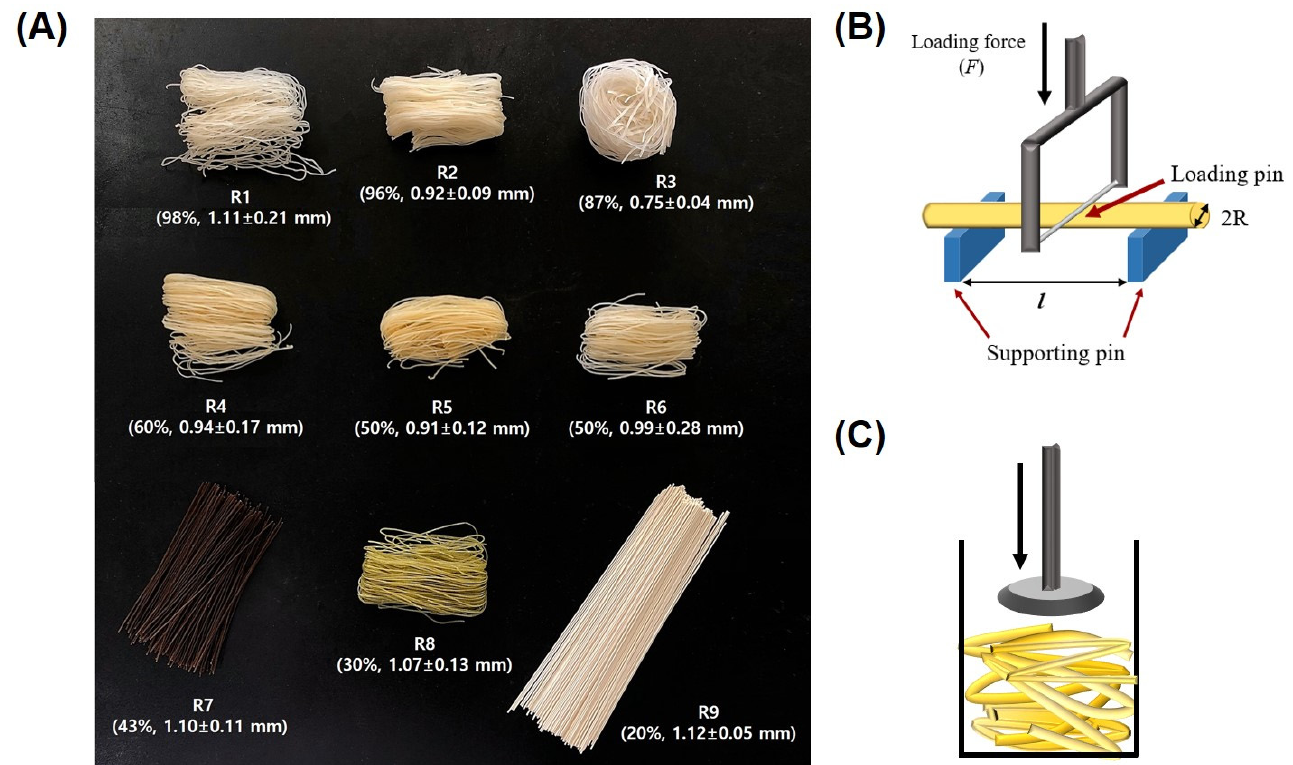
Figure 1. Appearance ( A ) and schematic images of the bending test ( B ) and stress–relaxation test ( C ) of commercial rice noodles.